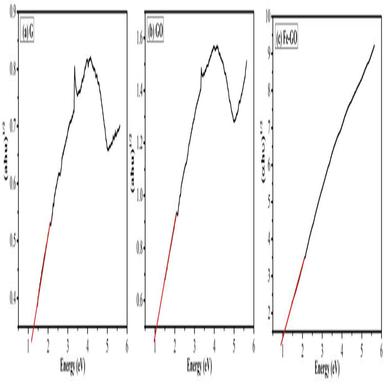
Tauc Plot for Band Gap Energy Calculation, featuring (a) Graphite (G), (b) Graphene Oxide (GO), and (c) the Fe-GO Nanocomposite.